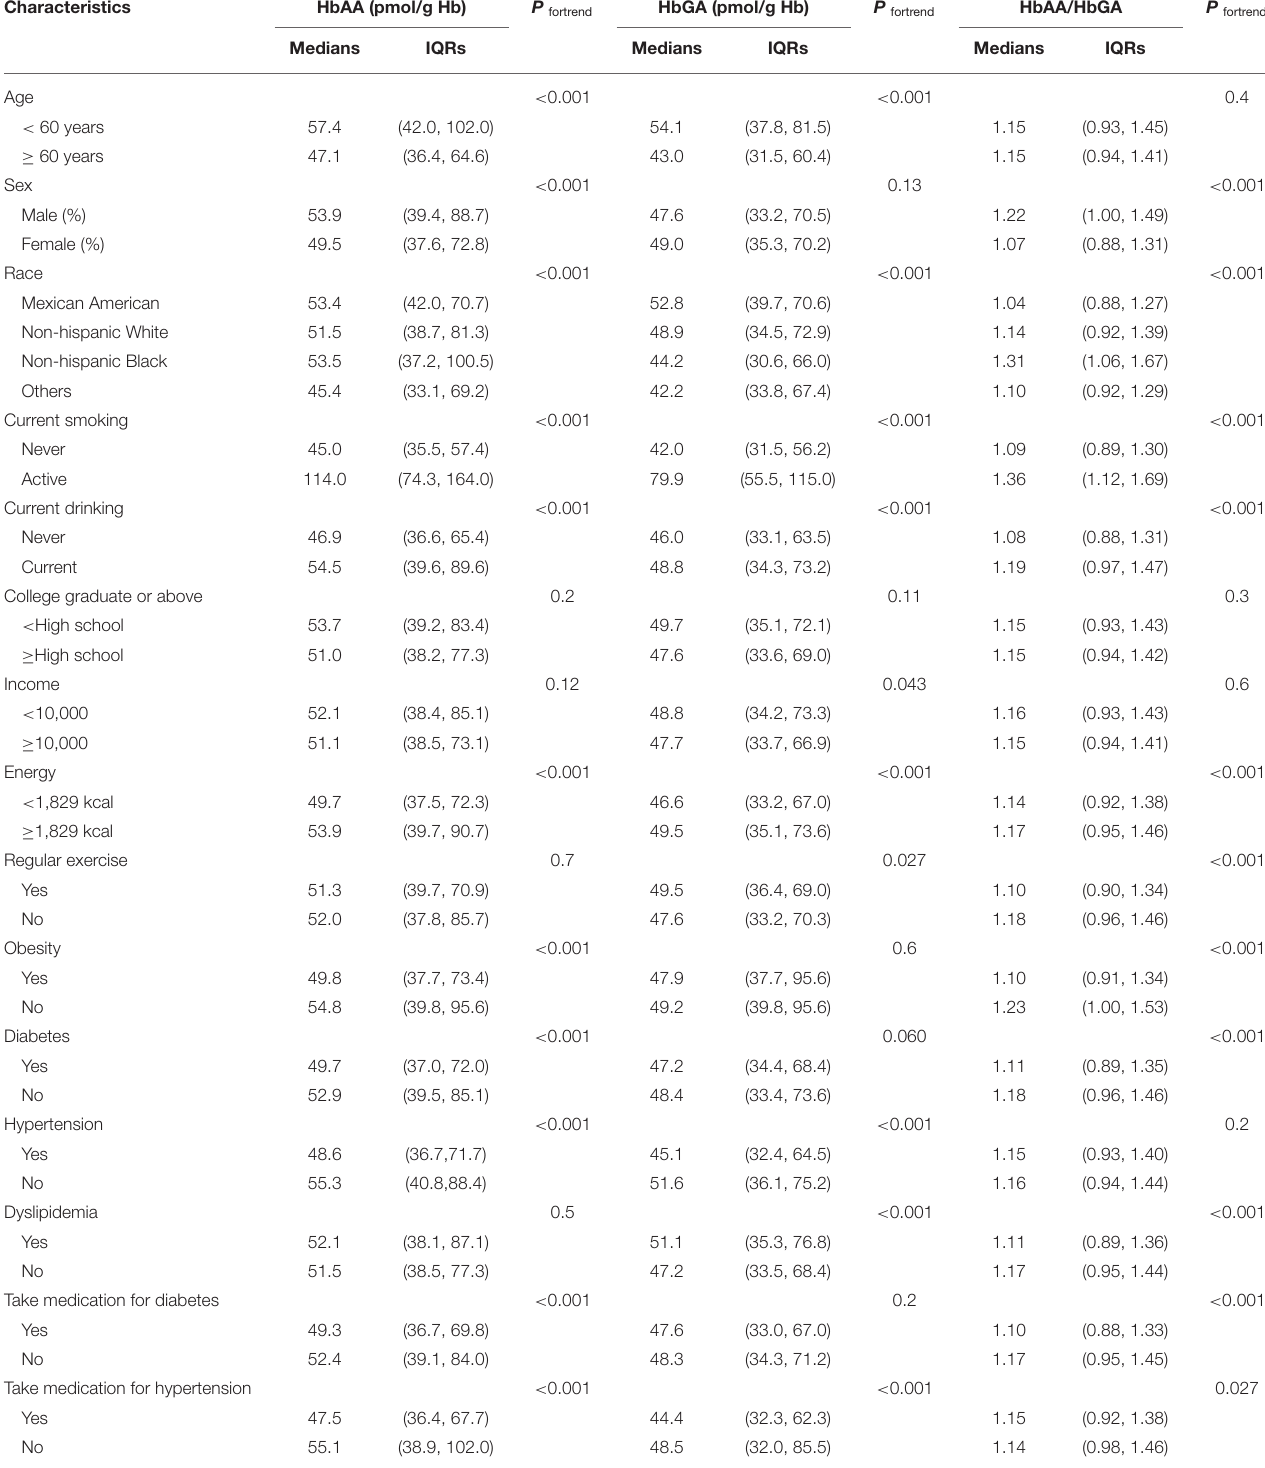
TABLE 1 | The hemoglobin biomarkers of hemoglobin adduct of acrylamide (HbAA), hemoglobin adduct of glycidamide (HbGA), and HbAA/HbGA are grouped by various characteristics of the total hyperglycemia population.